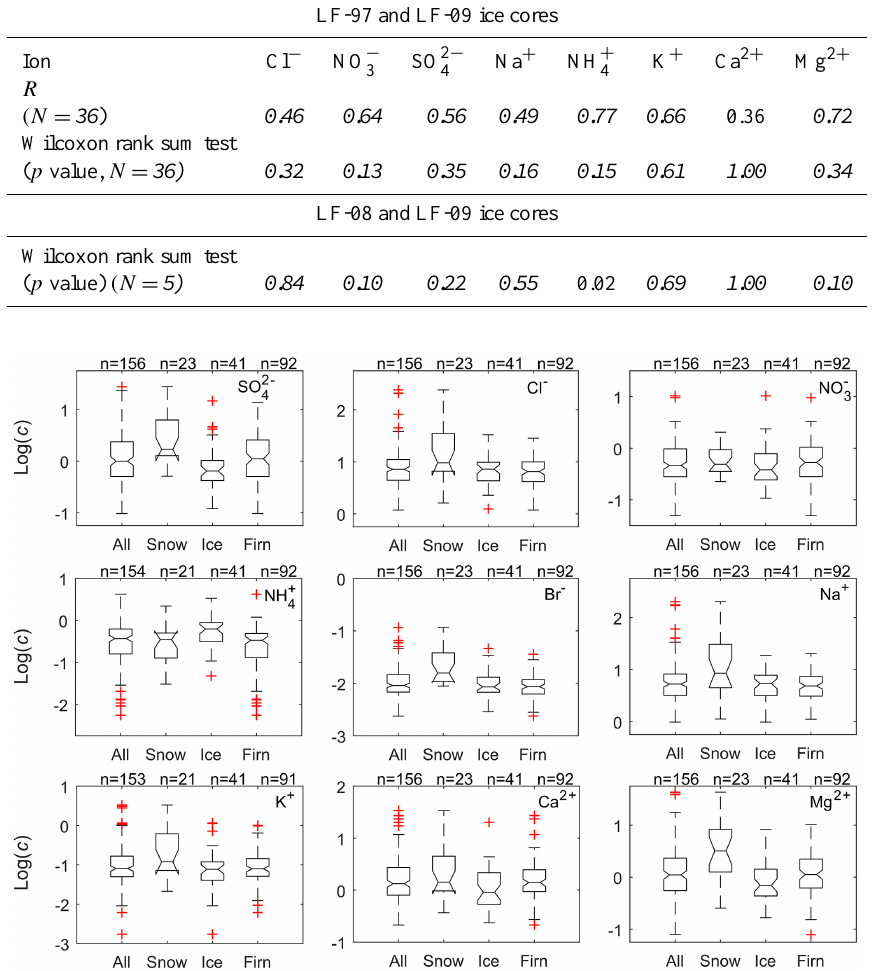
Table 3. Top table: Pearson coefficients ( R) and Wilcoxon rank sum test results ( p values), at a 95% confidence interval, between the different ions measured in the LF-97 and LF-09 ice cores (normalized concentrations and smoothed out as 5-year running averages). The overlapping period is 1957–1996. p values of the Pearson correlation have been corrected for the reduced degrees of freedom introduced by the 5-year smoothing. Significant values (correlation, p <0.05; Wilcoxon rank sum test p >0.05) are shown in italics. Bottom Table: Wilcoxon rank sum test at a 95% confidence interval between the different ions measured in the LF-08 and LF-09 ice cores (normalized concentrations and smoothed out as 5-year running averages). The overlapping period is 2000–2008. N represents the sample size.